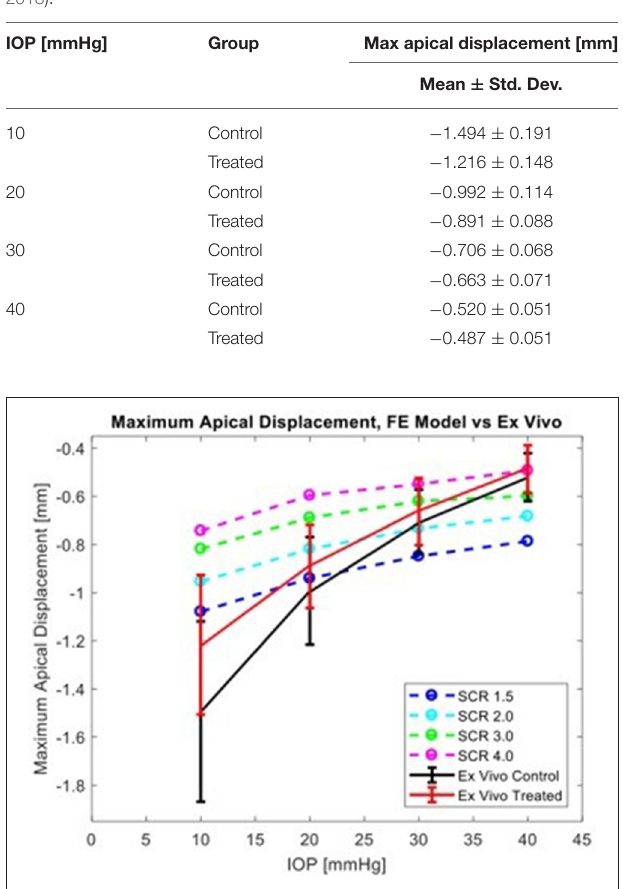
TABLE 6 | Summary of simulation results from FE model.